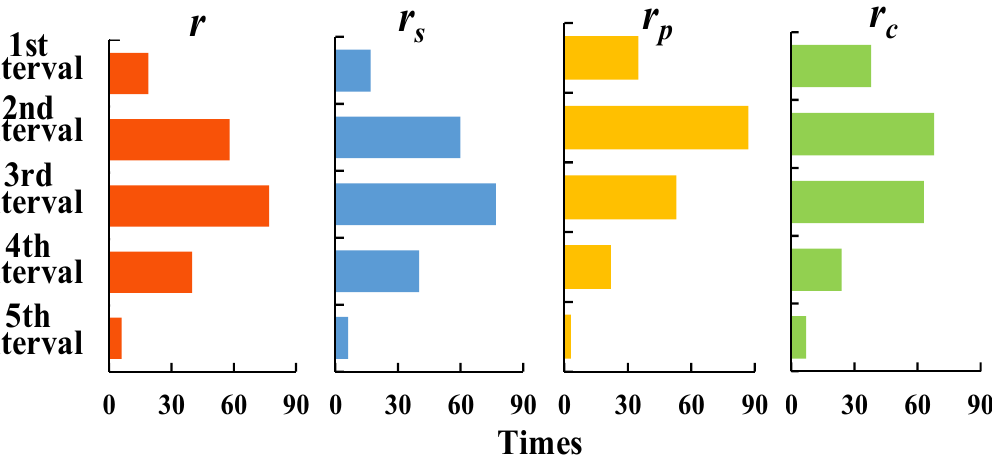
Appl. Sci. 2020, 10, 2013 Figure 8. Distributions of the construction schedules via r , as well as r s , r p , and r c .